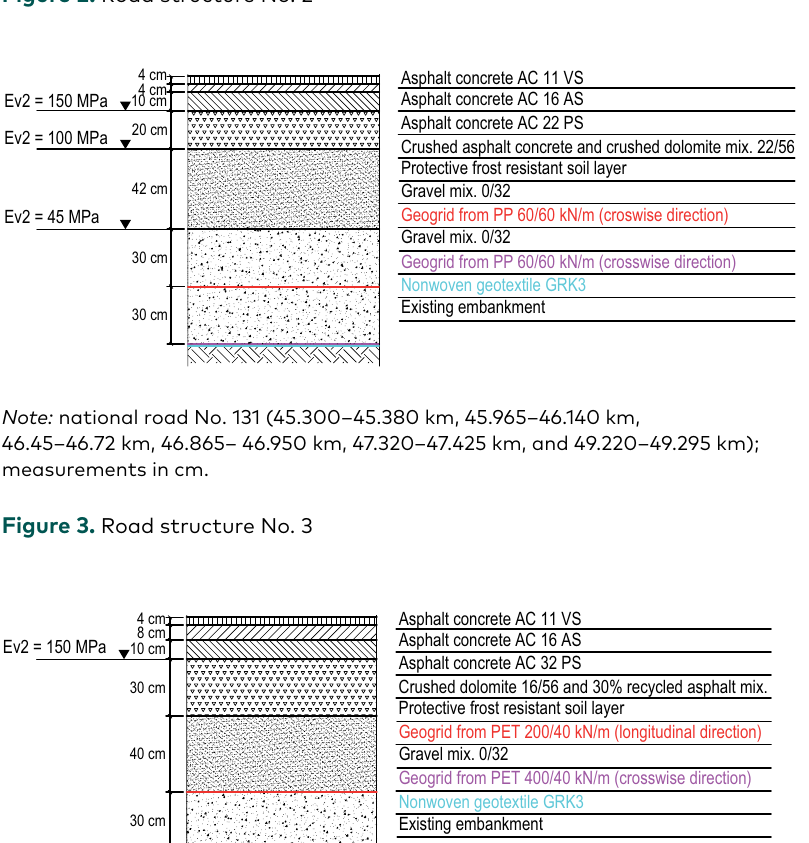
Figure 2. Road structure No. 2